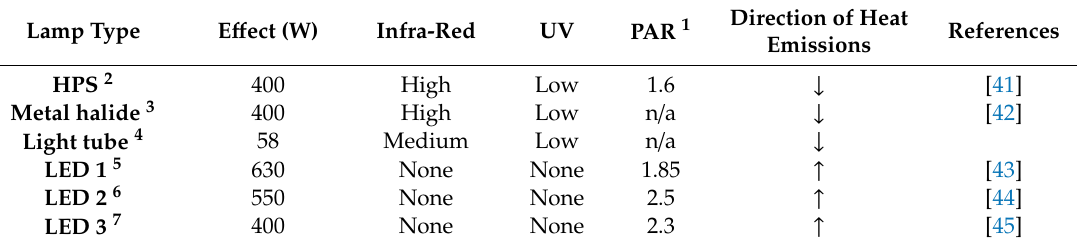
Table 1. Commonly used sources for artificial assimilation lighting (high-pressure sodium, HPS; metal halide; light tube; continuous spectrum polychromatic light-emitting diode (LED). Parameters of importance for plant–microbe interactions are displayed (ultraviolet light, UV; photosynthetically active radiation, PAR). Heat emissions directed towards ( ↓ ) or away from ( ↑ ) the crop are indicated by arrows. Lamp Type E ff ect